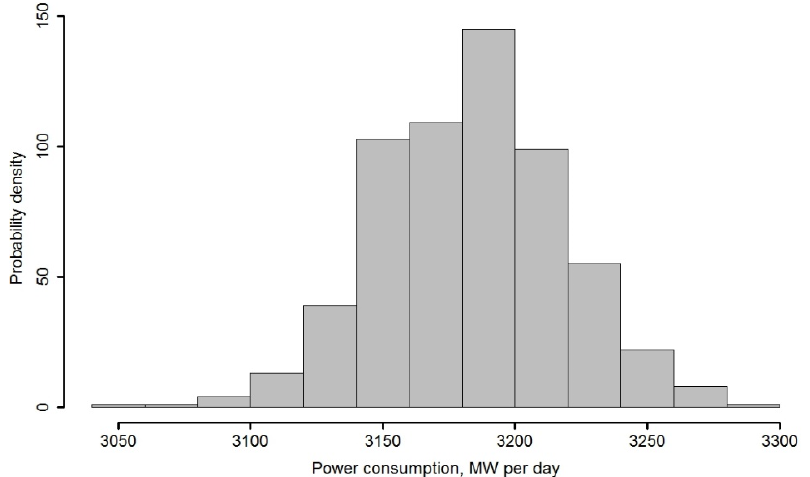
Figure 7. Power consumption distribution for a perfectly reliable network over 25 years.